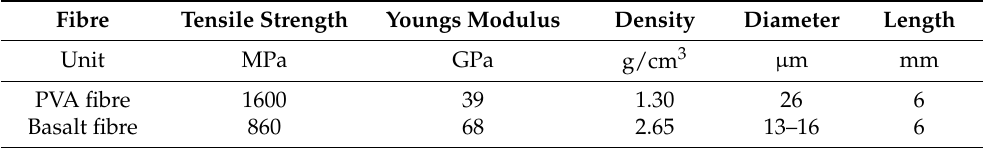
Table 2. Material properties of the used microfibres (manufacturer data).